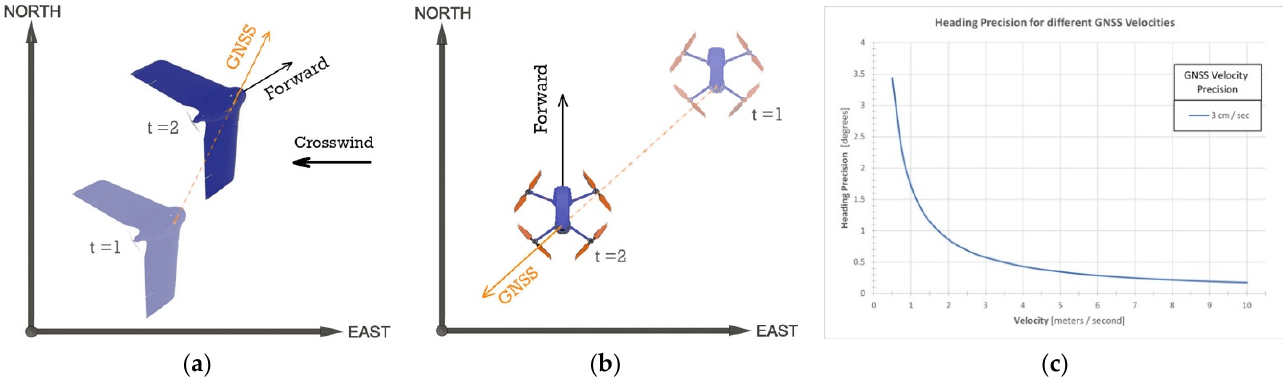
Figure 4. Misalignment of the forward axis of the navigation reference frame and the GNSS velocity vector for ( a ) fixed-wing UAS and ( b ) multirotor UAS. ( c ) Theoretical heading precision as a function of GNSS-derived velocity.